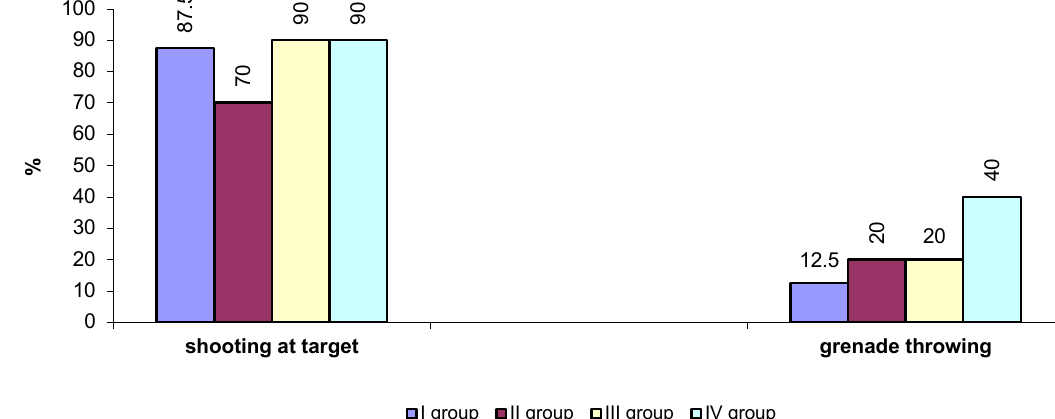
Fig.3. Time indicators of sharpshooting and grenade throwing, demonstrated by cadets of different specialties, %